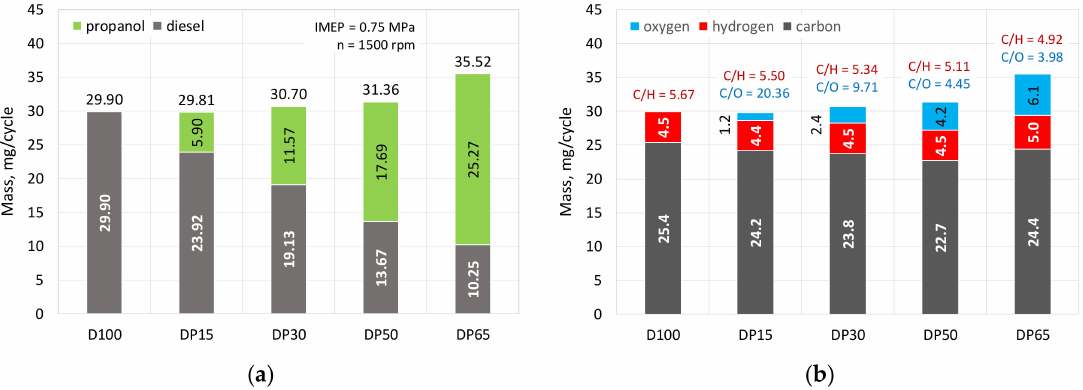
Figure 2. Mass of propanol and diesel fuel ( a ) and mass of carbon, hydrogen, and oxygen ( b ) in a dose of fuel supplied for one cycle of engine.